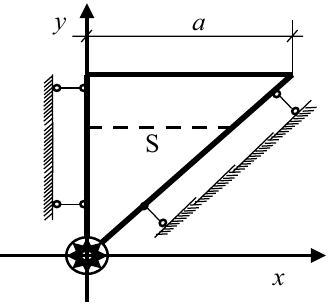
Figure 2. Simplified symmetrical computation sketch of the specimen.